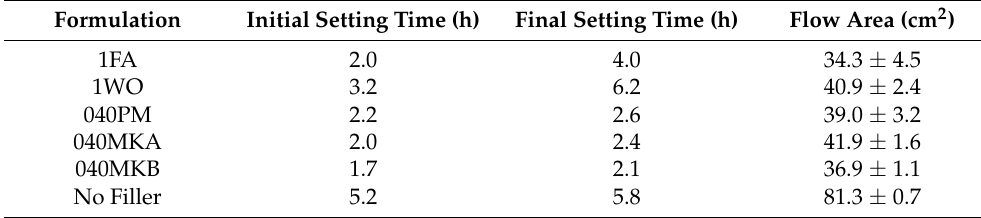
Table 3. Setting time and workability results of the MKPC mortars.